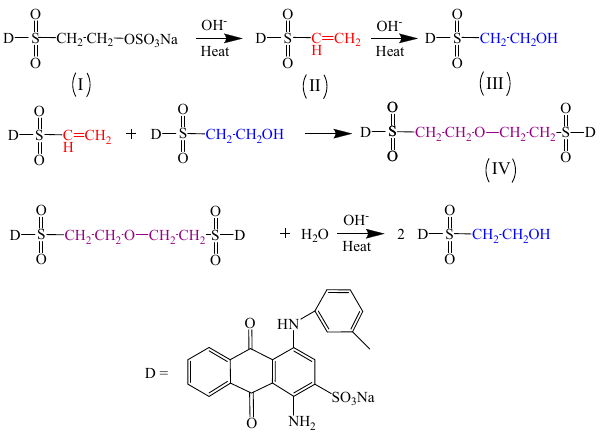
Figure 3. Hydrolytic route of C.I. Reactive Blue 19.